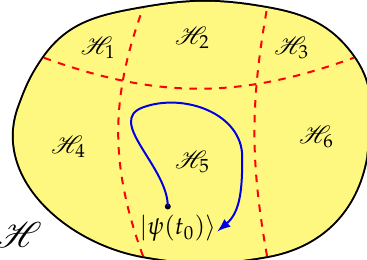
Figure 1. A pictorial representation of the partitioning of the Hilbert space H into QZSs H µ = P µ H . If the system is in a given QZS at the initial time t 0 , it will evolve coherently in this subspace and will never make a transition to the other